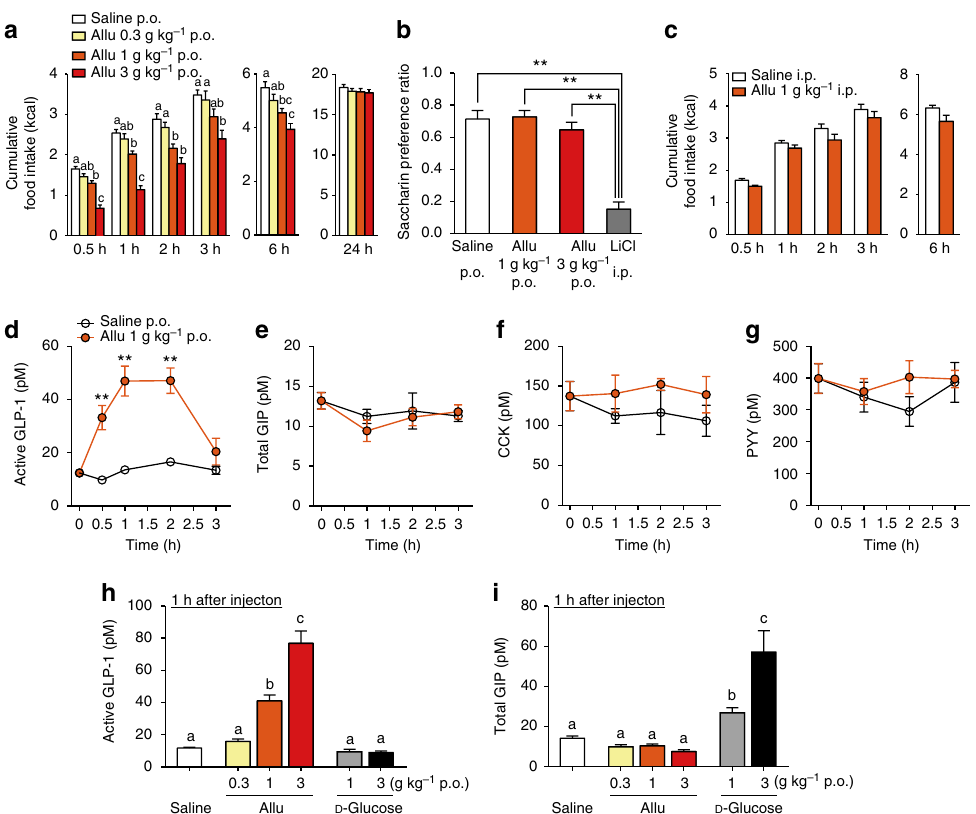
Fig. 1 Peroral D -allulose suppresses food intake and releases GLP-1 in normal mice. a Cumulative food intake at 0.5 – 24 h after p.o. administration of 0.3, 1, and 3 g kg − 1 D -allulose (Allu) in C57BL/6J mice fasted overnight (16 h). n = 10. Different letters indicate p < 0.05 by one-way ANOVA followed by Tukey ’ s test in each time. b In conditioned taste aversion test, saccharin preference was measured at 2 days after injection of saline, Allu, or lithium chloride (LiCl; 3 mmolkg − 1 ). n = 5 – 8. ** p < 0.01 by one-way ANOVA followed by Tukey ’ s test. c Cumulative food intake after intraperitoneal (i.p.) injection of 1 g kg − 1 Allu. n = 8. d – g Time course of active GLP-1 ( d ), total GIP ( e ), CCK ( f ), and PYY ( g ) concentrations in portal vein plasma after 1 g kg − 1 Allu or saline p.o. injection. n = 5 – 9. ** p < 0.01 by two-way ANOVA followed by Bonferroni ’ s test vs. saline. h , i Active GLP-1 ( h ) and total GIP ( i ) concentrations in portal vein at 1 h after p.o. administration of increasing concentrations of Allu or D -glucose. n = 5 – 15. Different letters indicate p < 0.05 by one-way ANOVA followed by Tukey ’ s test. Error bars are